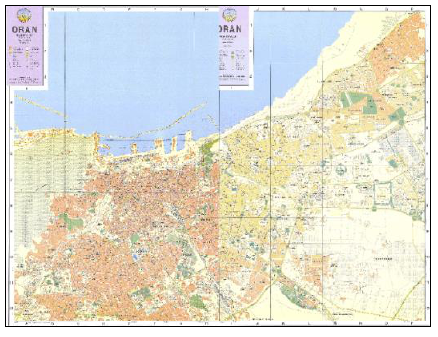
Figure 3. The city map of Oran (Reference Data) 3.1.2